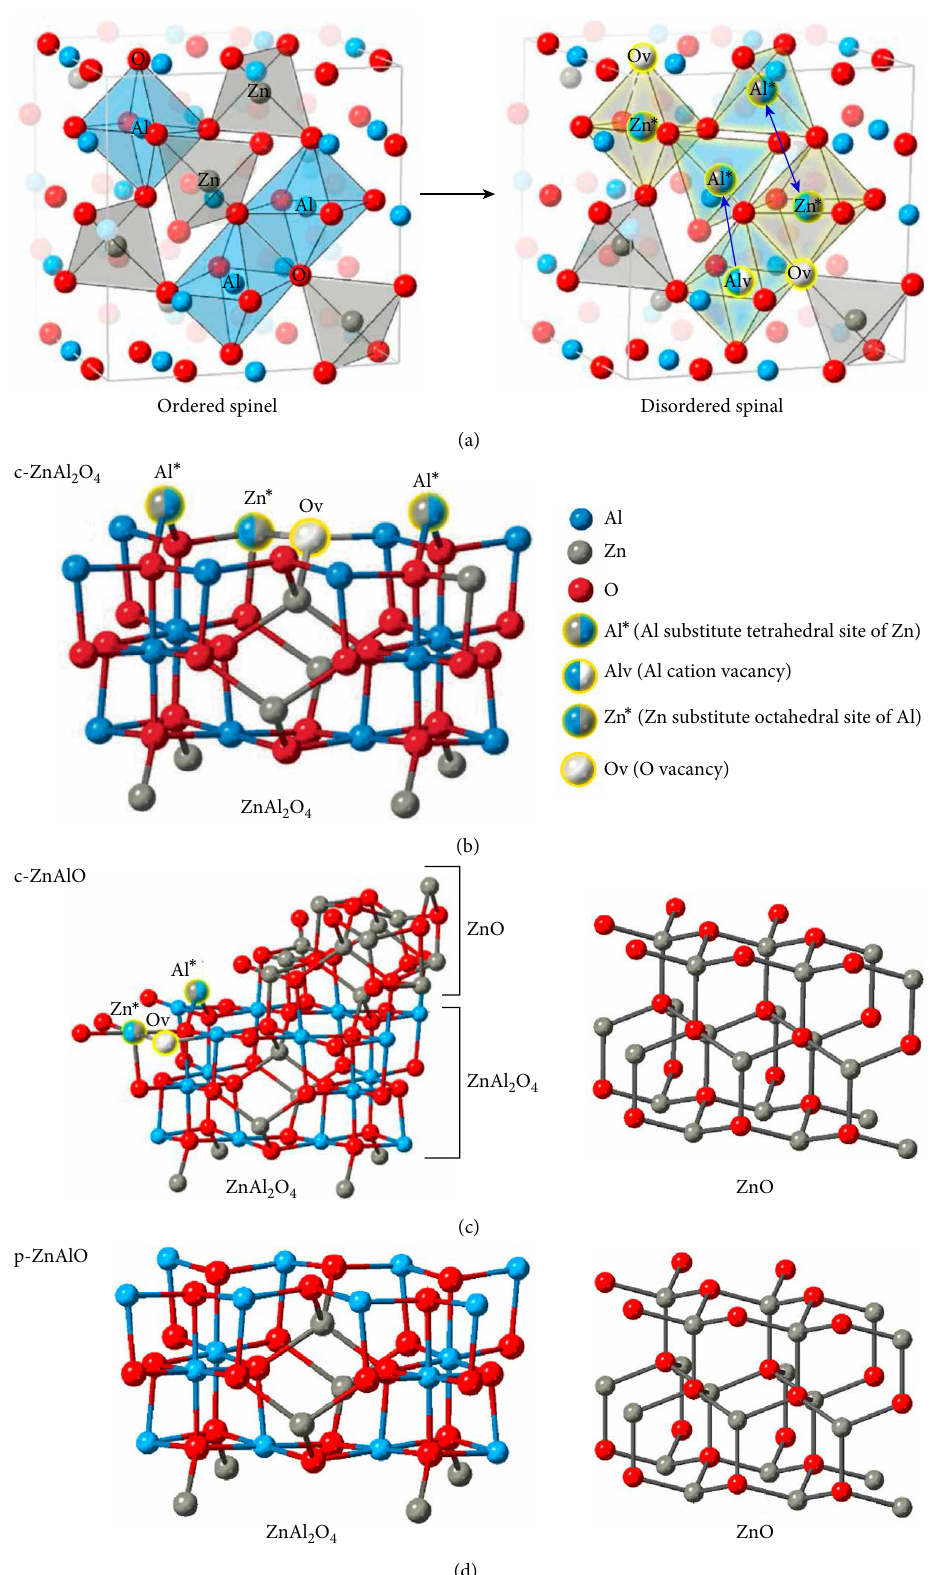
Scheme 7: Lattice structure of (a) ordered and disordered spinel ZnAl from Ref. [57] with permission, Copyright 2019